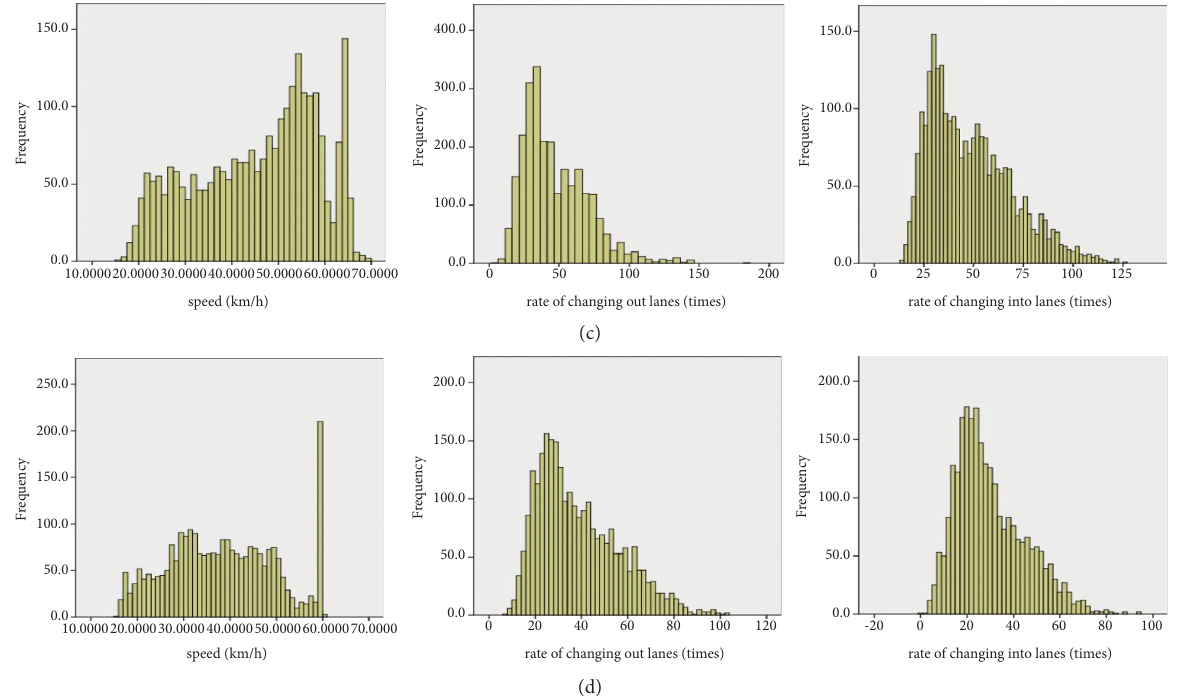
Figure 6: Simulation data distribution histogram. (a) The histogram of Lane 1 speed, the rate of changing into lanes, and the rate of changing out of lanes. (b) The histogram of Lane 2 speed, the rate of changing into lanes, and the rate of changing out of lanes. (c) The histogram of Lane 3 speed, the rate of changing into lanes, and the rate of changing out of lanes. (d) The histogram of Lane 4 speed, the rate of changing into lanes, and the rate of changing out of